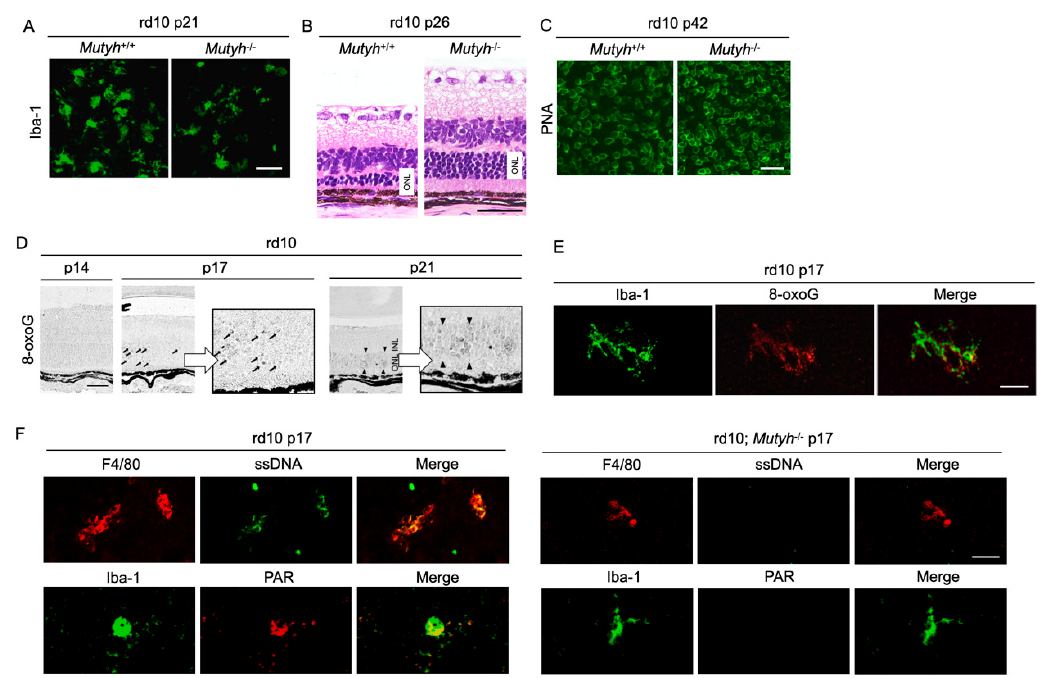
Figure 5. The Figure is reproduced from [59] with copyright permission. Oxidative DNA damage in microglia mediates retinal inflammation and degeneration through Mut Y homolog activation. ( A – C ) Immunohistochemical staining of microglial marker Iba-1 ( A ), hematoxylin and eosin staining ( B ), and peanut agglutin (PNA) staining, which labels the cone inner and outer segments ( C ) in rd10 mice or rd10 mice deficient for Mut Y homolog ( Mutyh ) (rd10; Mutyh − / − ). Note that microgliosis and rod as well as cone degeneration are suppressed by Mutyh deficiency. ONL: outer nuclear layer. Scale bar, 50 µ m ( A , B ), 20 µ m ( C ). ( D ). Time-dependent changes of oxidative DNA damage in rd10 mice. Scattered 8-oxoG accumulation is observed at early phase of retinal degeneration (postnatal day 17: P17), and thereafter 8-oxo-G accumulation expands to the ONL diffusely at P21 in rd10 mice. Scale bar, 50 µ m. ( E ) Part of scattered 8-oxo-G staining in the P17 rd10 retinas are colocalized with Iba-1-positive microglial cells, suggesting that 8-oxo-G accumulation in microglia precedes the peak of photoreceptor cell death in rd10 mice. Scale bar, 20 µ m. ( F ) Immunohistochemical staining of single-strand DNA (ssDNA) to detect single-strand breaks (SSBs) and poly(ADP-ribose) (PAR) for the marker of poly(ADP-ribose) polymerase (PARP) activation in rd10 or rd10; Mutyh − / − mice. Microglia in rd10 mice are associated with SSB formation and PARP activation, which is reversed by Mutyh deficiency. Scale bar, 20 µ m.